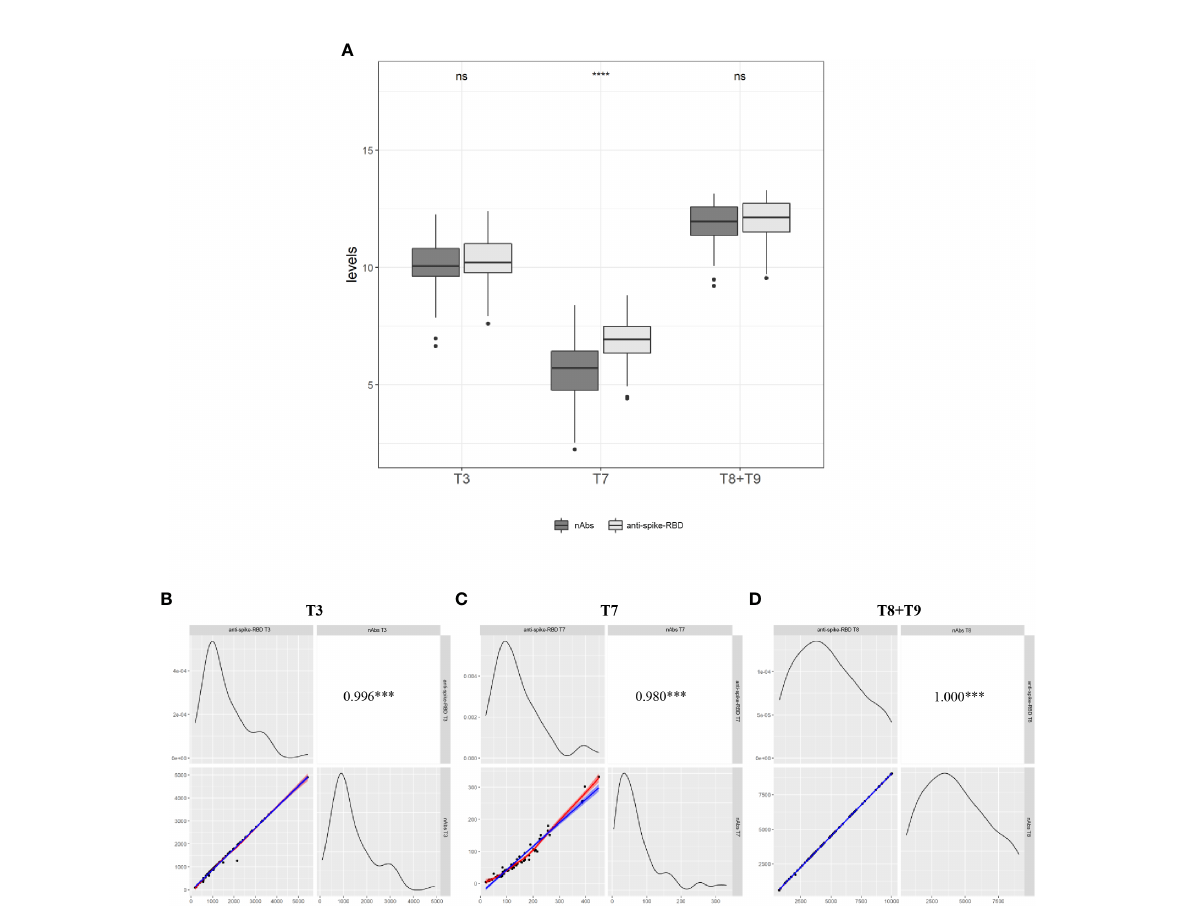
FIGURE 3 Relationship between anti-spike-RBD and anti-nAbs (A) The evaluation of both antibodies was conducted on a total of 71 participants (Group 1=41 and Group 2= 30) one month after the second dose (T3), 7.2 months after the second dose (T7) and one month after the third dose (T8 for Group and T9 for Group 2. Data merging = T+T9). (B) Correlation between anti-spike-RBD and anti-nAbs at T3, (C) at T7, and (D) at T8+T9. Statistical signi fi cance was indicated by the star symbols (i.e., ns: p > 0.05, ***p ≤ 0.001, ****p ≤